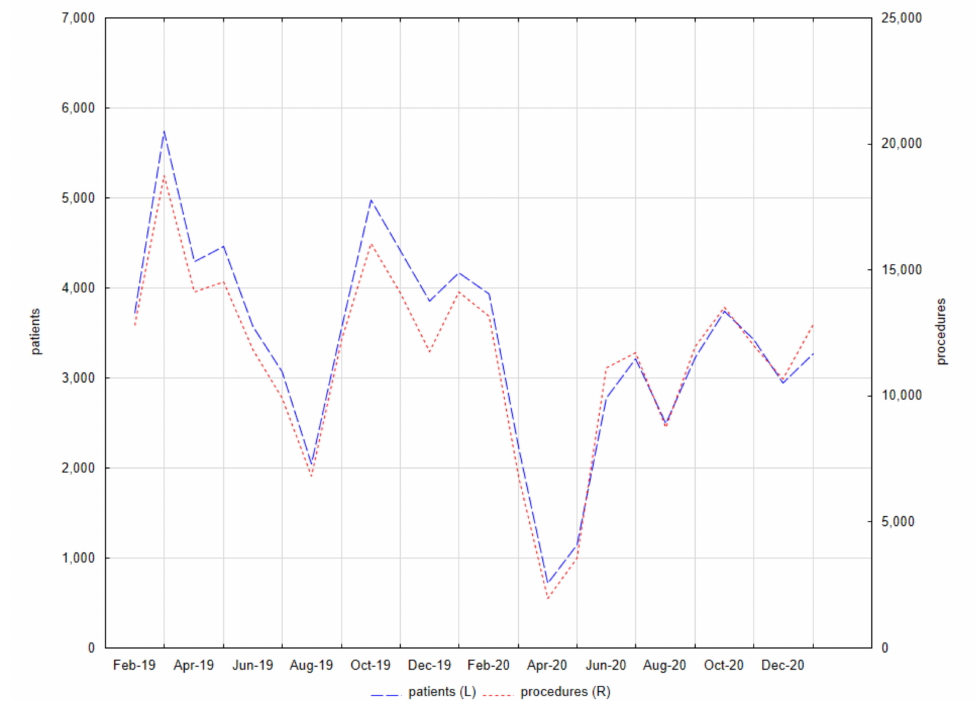
Figure 1. Patients and procedures in the University Center of Dentistry and Specialized Medicine (Poznan, Poland) from 1 February 2019 to 31 January